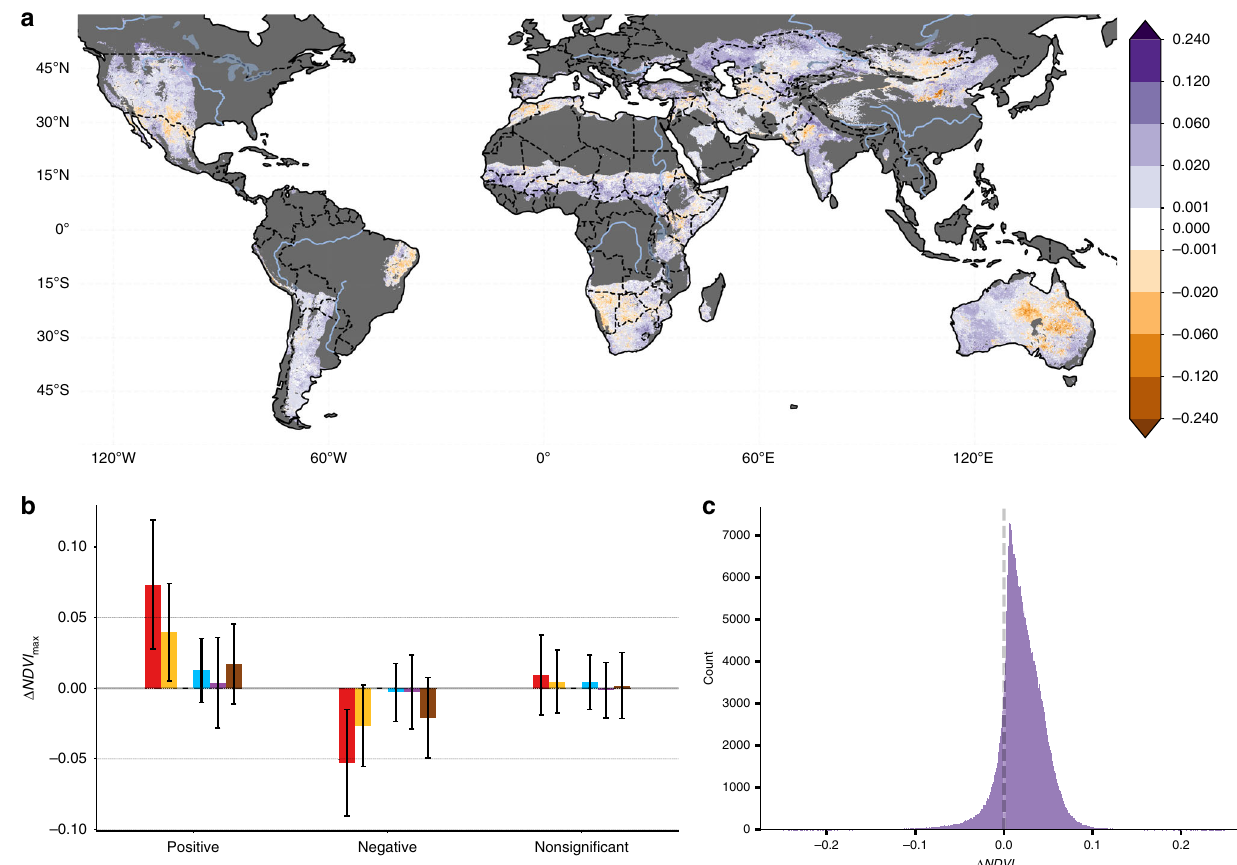
Fig. 2 The contribution of anthropogenic climate change to vegetation change from 1982 to 2015. a The contribution of anthropogenic climate change (Climate Change + O 2 ) component to the change in vegetation between 1982 and 2015 ( Δ NDVI max ). Non-dryland and hyper-arid regions are masked in dark gray and areas where the change is insigni fi cant ( α FDR = 0.10) or smaller than the error in the sensors (±0.001) are masked in white. b The mean area-weighted pixel effect size of the drivers of observed vegetation broken down by observed vegetation change direction. Positive indicates greening and negative is deserti fi cation. Error bars show the SD. c Frequency distribution function for the change in NDVI max (1982 – 2015) attributed to by anthropogenic climate